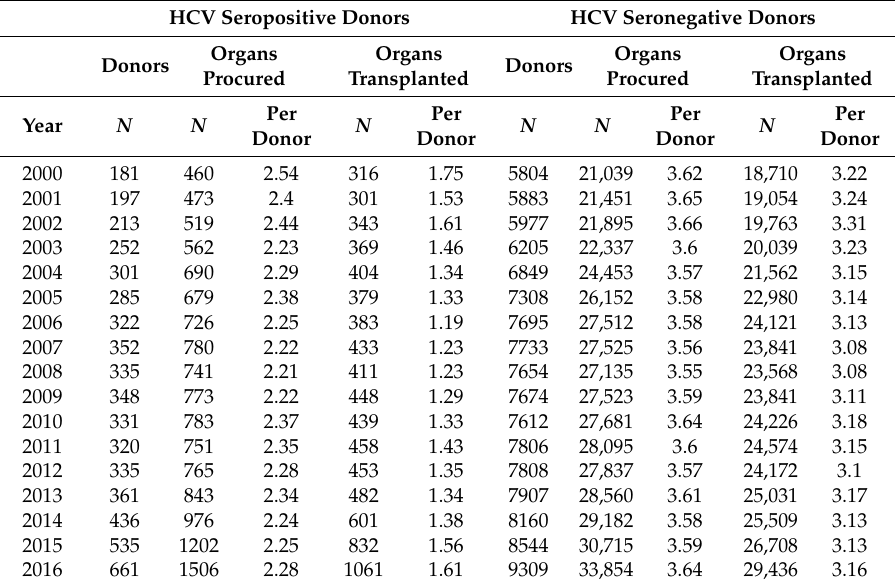
Figure 1. Trends in organ utilization from hepatitis C virus (HCV) seropositive donors. ( A ) Organs procured and transplanted from HCV seropositive donors by year; ( B ) Utilization rate (percentage organs procured that were transplanted) by HCV donor serostatus for liver and kidney transplantation. HCV+, HCV seropositive; HCV − , HCV seronegative. Table 1. Organs procured and transplanted by HCV donor serostatus.